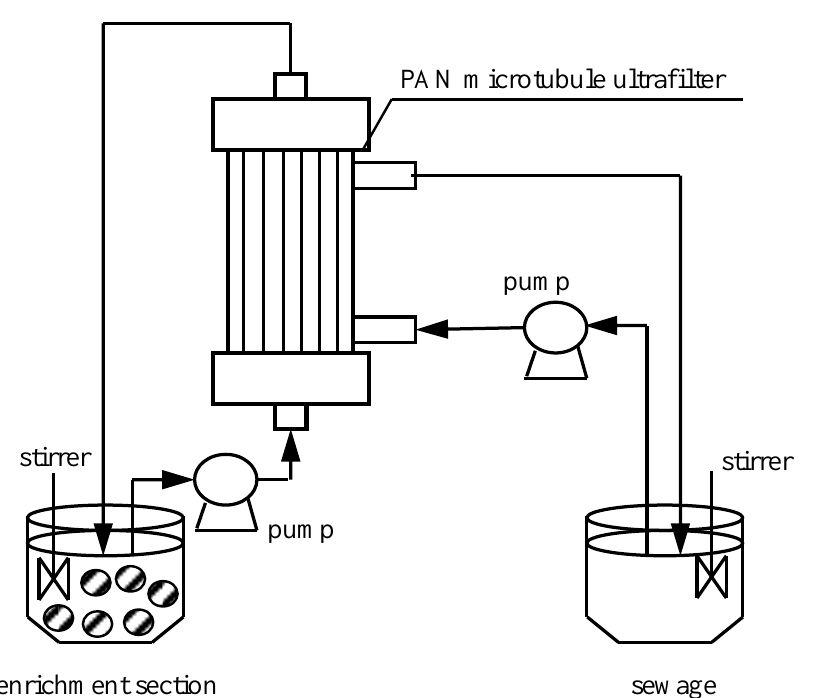
Figure 1. Installation of PAN microtubule ultrafiltration reactor process.